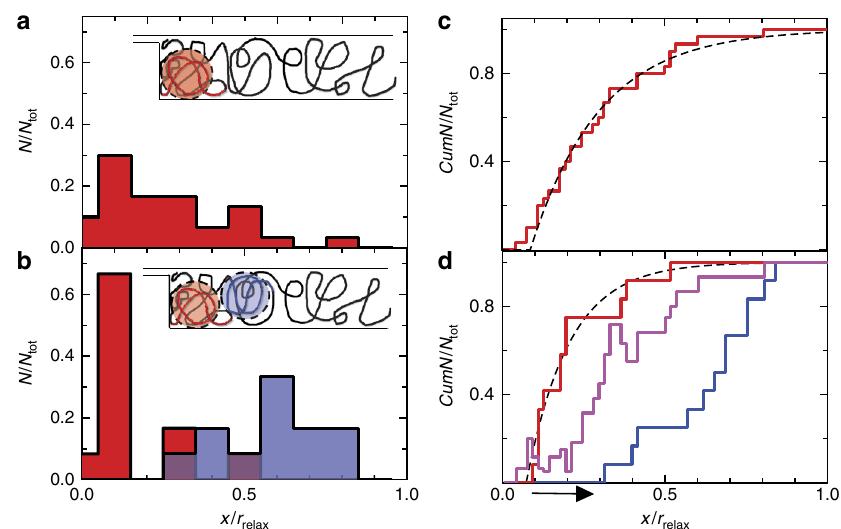
Fig. 6 Knot position histograms. a Knot position histogram for one-knot states and b two-knot states 2 s after pressure release. c Cumulative knot position histogram for one-knot states and d two-knot states normalized to the total number of counts. The x -axis is normalized to the extension r relax of the relaxing molecule measured at the time for which the knot-position was obtained. The data used includes events with R b ≈ 0.11, 0.13, 0.17. For the two-knot states, we separately histogram the position of the knot closest to the barrier (lower knot, shown in red) and the knot farthest from the barrier (upper knot, shown in blue). The dashed curves in c and d are best- fi ts of respective data to the cumulative distribution corresponding to an exponential probability distribution. The arrow in d indicates that the upper knot distribution is shifted relative to the estimated non-interacting distribution (bold Figure 4b gives the extracted free energies for forming a one knot state and knot interaction free energies as a function of R b .